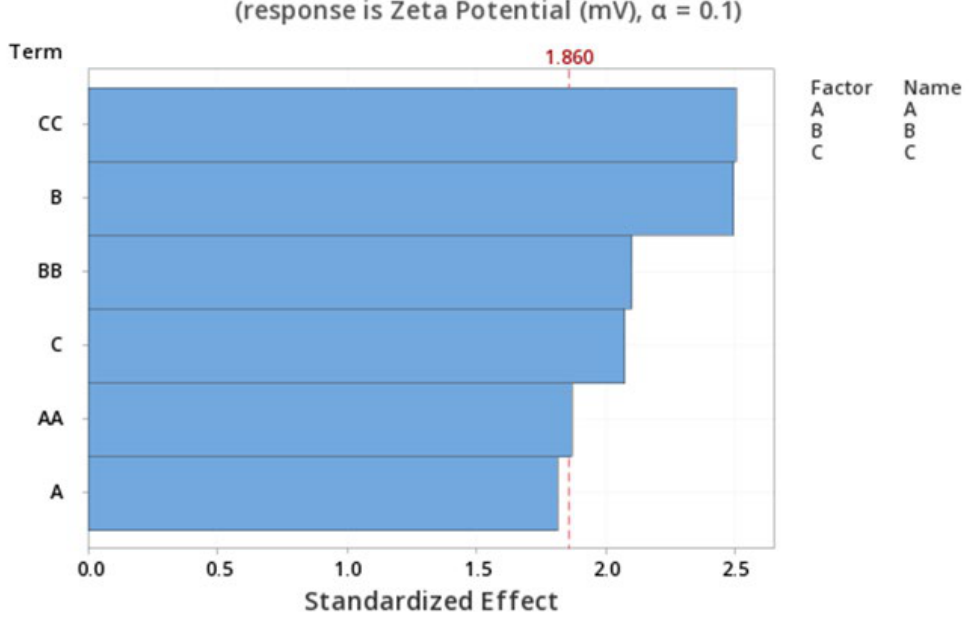
Figure 4. Pareto chart expressing the standardized effect of independent variables and their interac- tion on the charge of the NPs.